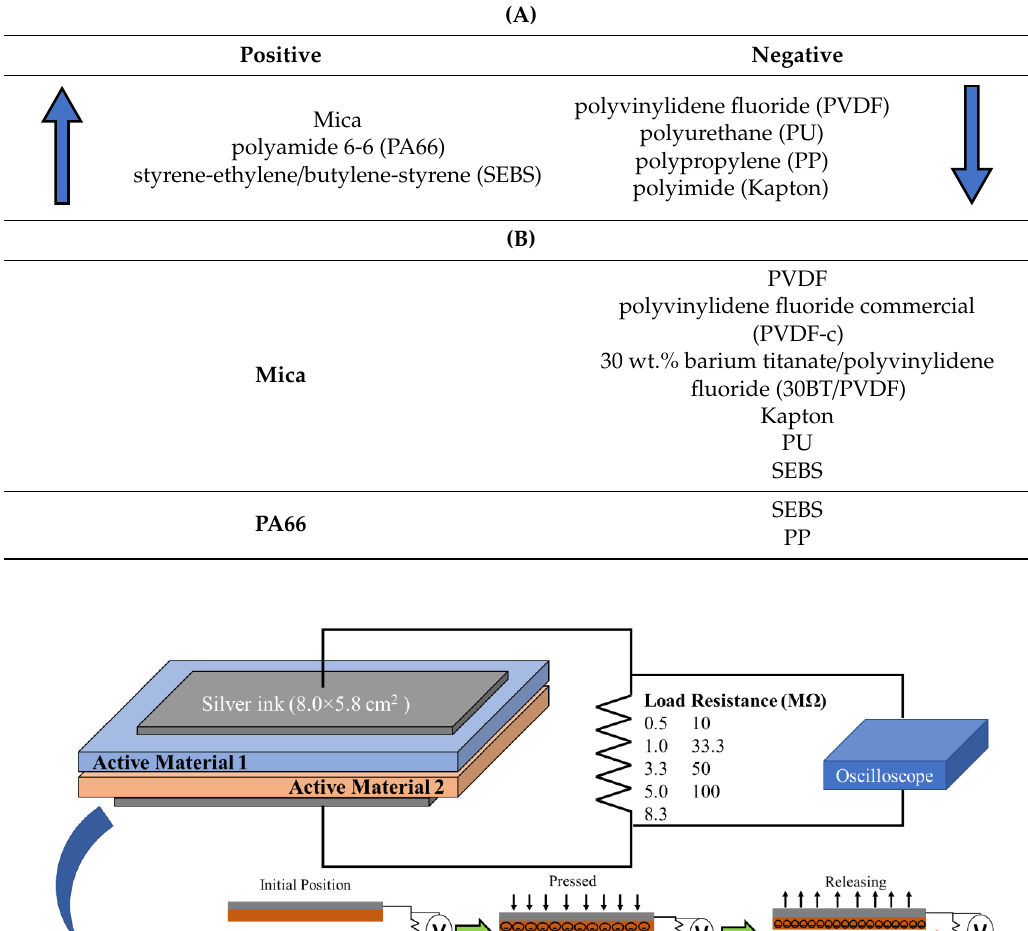
Table 1. ( A ) Materials within the triboelectric series used in the present work [27,28] and ( B ) pair of materials used in the contact-separation mode triboelectric experiments.